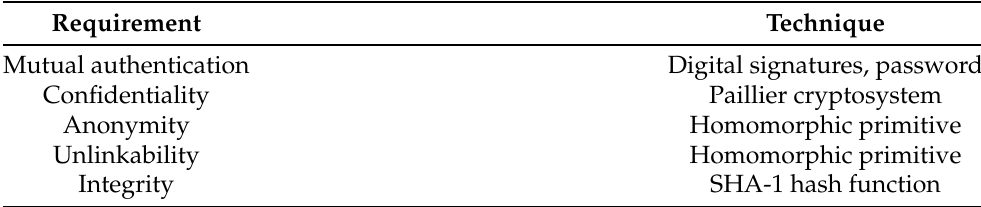
Table 8. Security